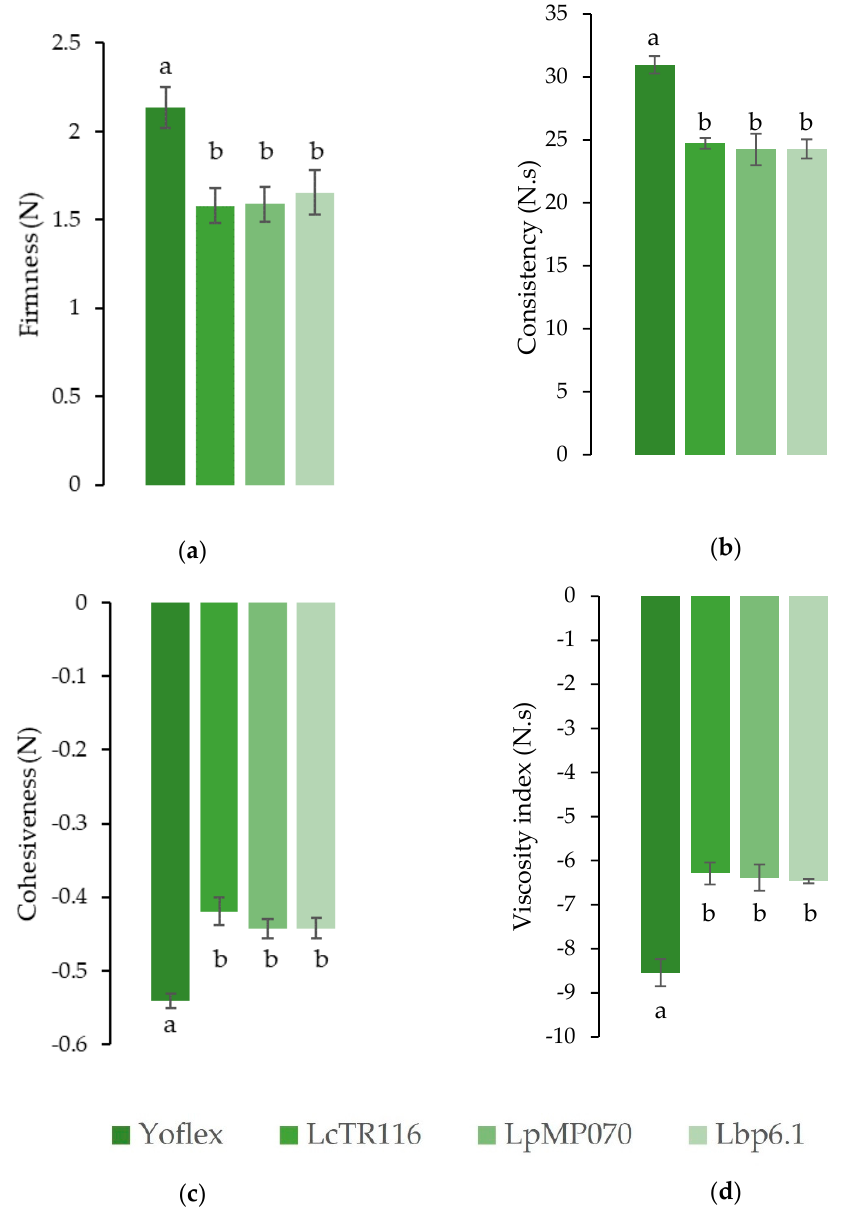
Figure 3. Averages and standard deviations of ( a ) firmness, ( b ) consistency, ( c ) cohesiveness, and ( d ) viscosity index of the fermented samples as measured by uniaxial compression testing. Values with the same superscript letters are not significantly different ( p > 0.05).